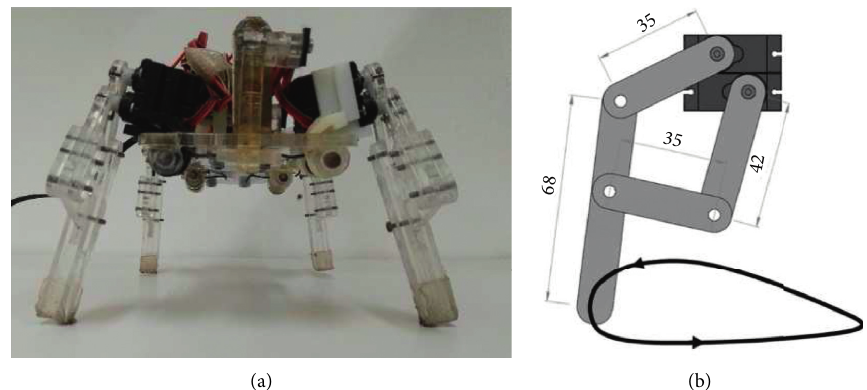
Figure 2: The overall robot structure: (a) the passive DOF; (b) the four-bar mechanism leg structure and the implemented foot’s path.